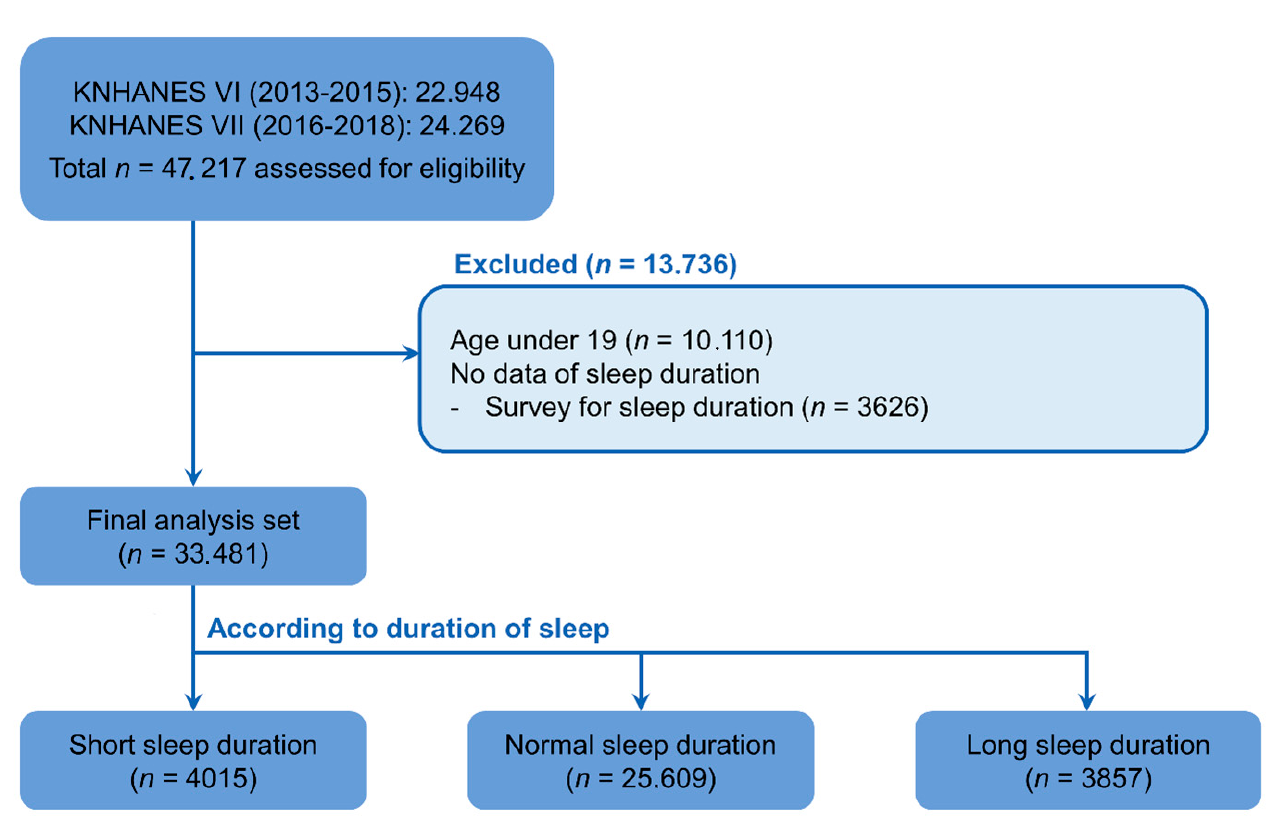
Figure 1. Flow chart of study subjects included in the 2013 to 2018 Korea National Health and Nutrition Examination Surveys (KNHANES VI and VII).